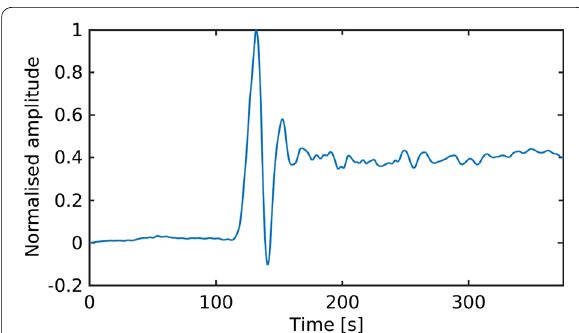
Fig. 9 Normalized time-dependent seismic moment. Note that it is not possible to say if the static offset remains at the 40% of the peak amplitude or slowly decreases toward zero at later times, thus forming a sawtooth